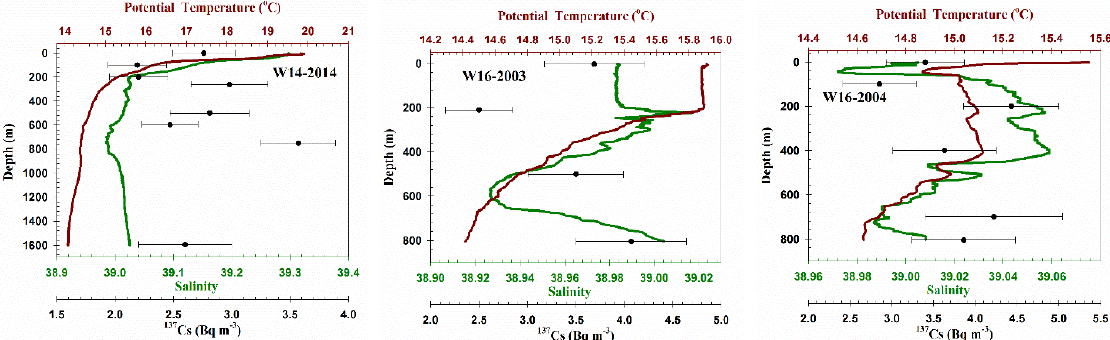
Figure 4. Vertical profiles of 137 Cs activity concentrations and oceanographic parameters from pre- vious campaigns from the North Cretan basin in 2017; and Myrtoan basin in 2003 and 2004, respec-